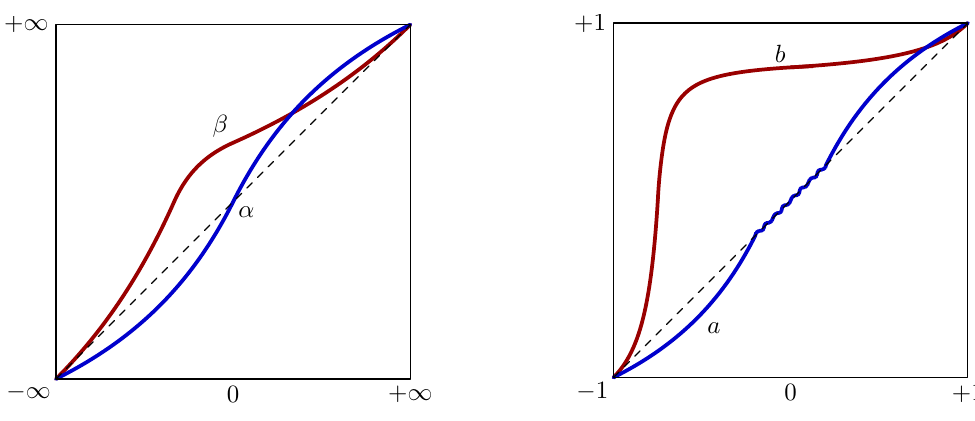
Figure 1: The standard affine action of BS ( 1 , 2 ) (left) and an action à la Denjoy (right).